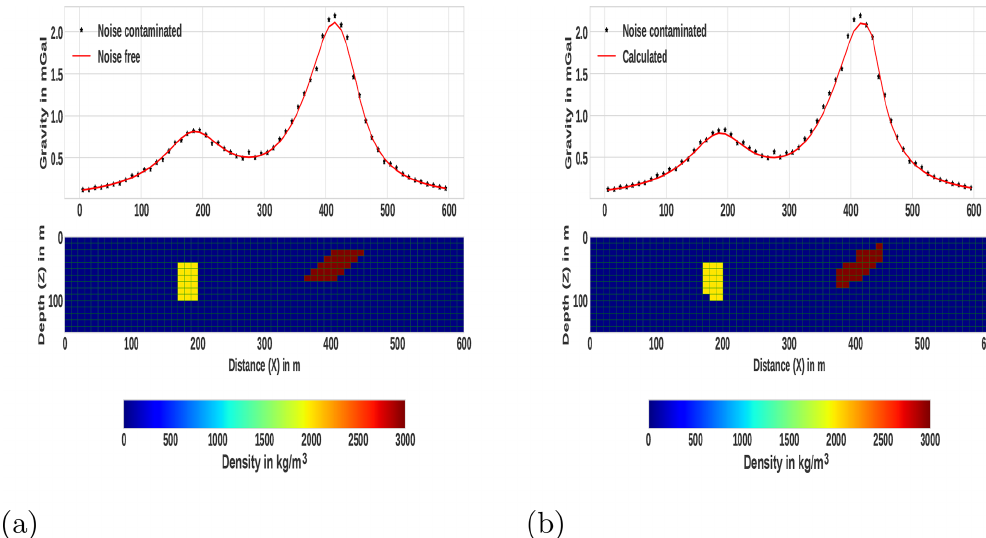
Figure 5. The second example synthetic model and the corresponding inversion result. (a) Synthetic model consisting of a dipping dike and vertical rectangular block and the corresponding gravity data. (b) The density model obtained by inverting the gravity data using the developed method. The predicted data as a result of inversion process are shown on the top panels (solid line).